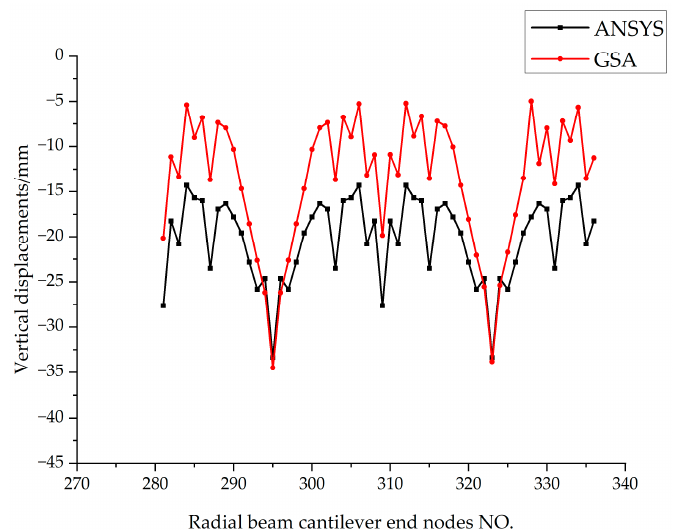
Figure 11. Radial beam cantilever ends’ vertical displacements comparison curve (mm).